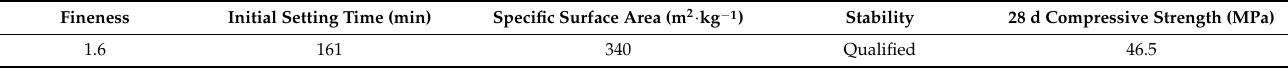
Table 2. Performance indexes of